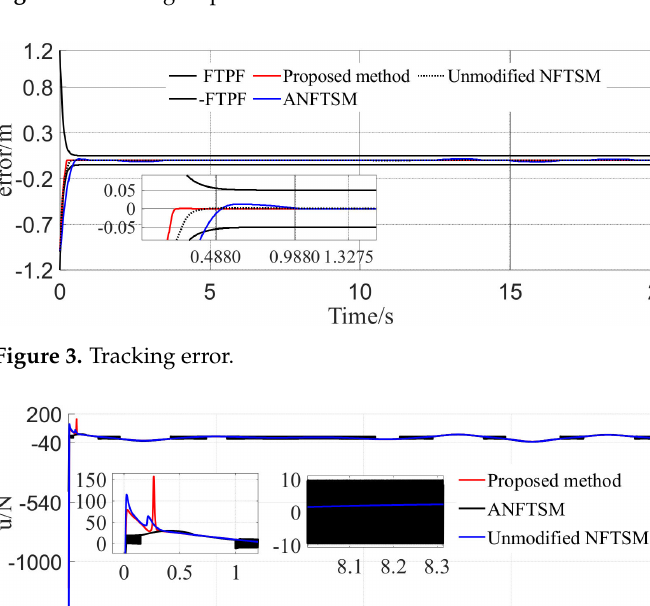
Figure 2. Tracking response.